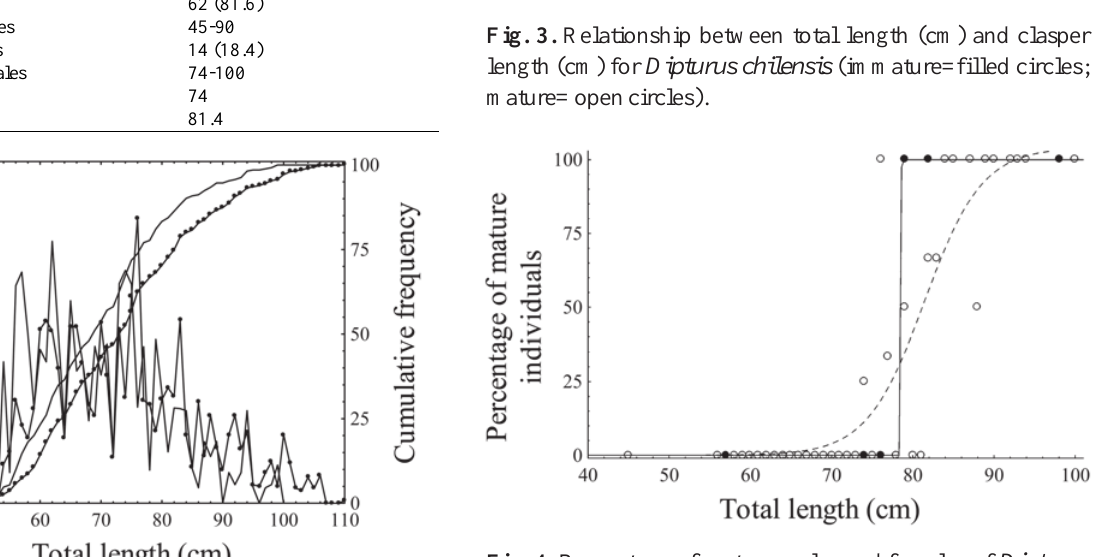
Fig. 4. Percentage of mature males and females of Dipturus chilensis by total length class of 1.0 cm. Line represents the logistic model adjusted (solid line, filled circles = males, dot- ted line,open circles